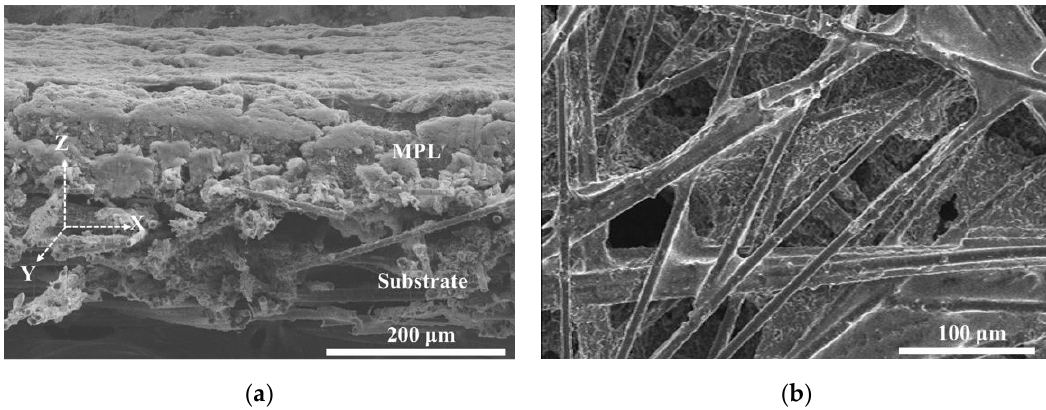
Figure 1. Direction definition of a carbon paper GDL (JNT 30-A1, with the original size of X (300 mm) · Y (210 mm) · Z (320 ± 20 μm )) in ( a ) and the microstructural observation of carbon fibers in the substrate in ( b ) .